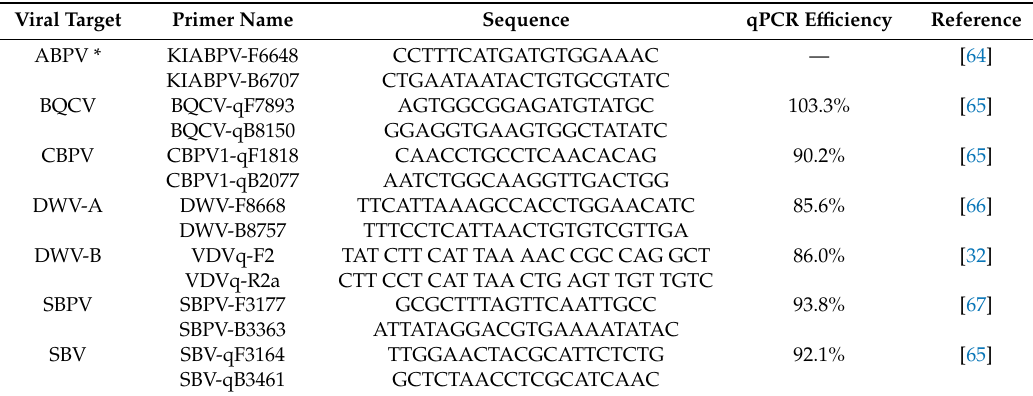
Table A1. List of primers used for quantification of viruses by reverse transcription followed by qPCR and e ffi ciency of